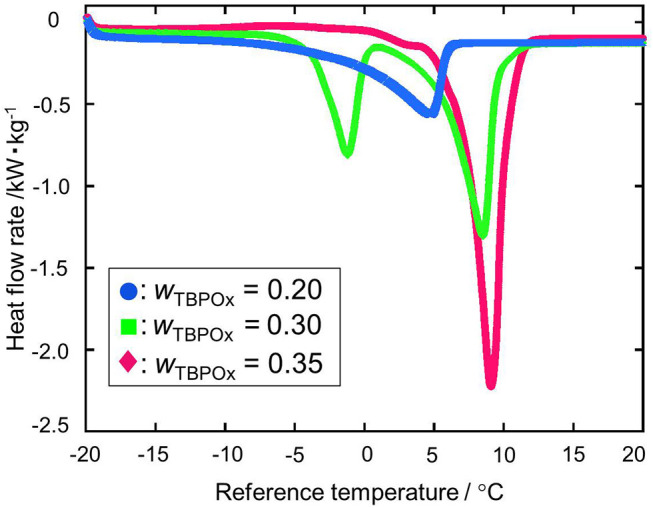
The heat flow rate at the mass fractions 0.20, 0.30, and 0.35: blue •, wTBPOx = 0.20; green ■, wTBPOx = 0.30; red ♦, wTBPOx = 0.35.